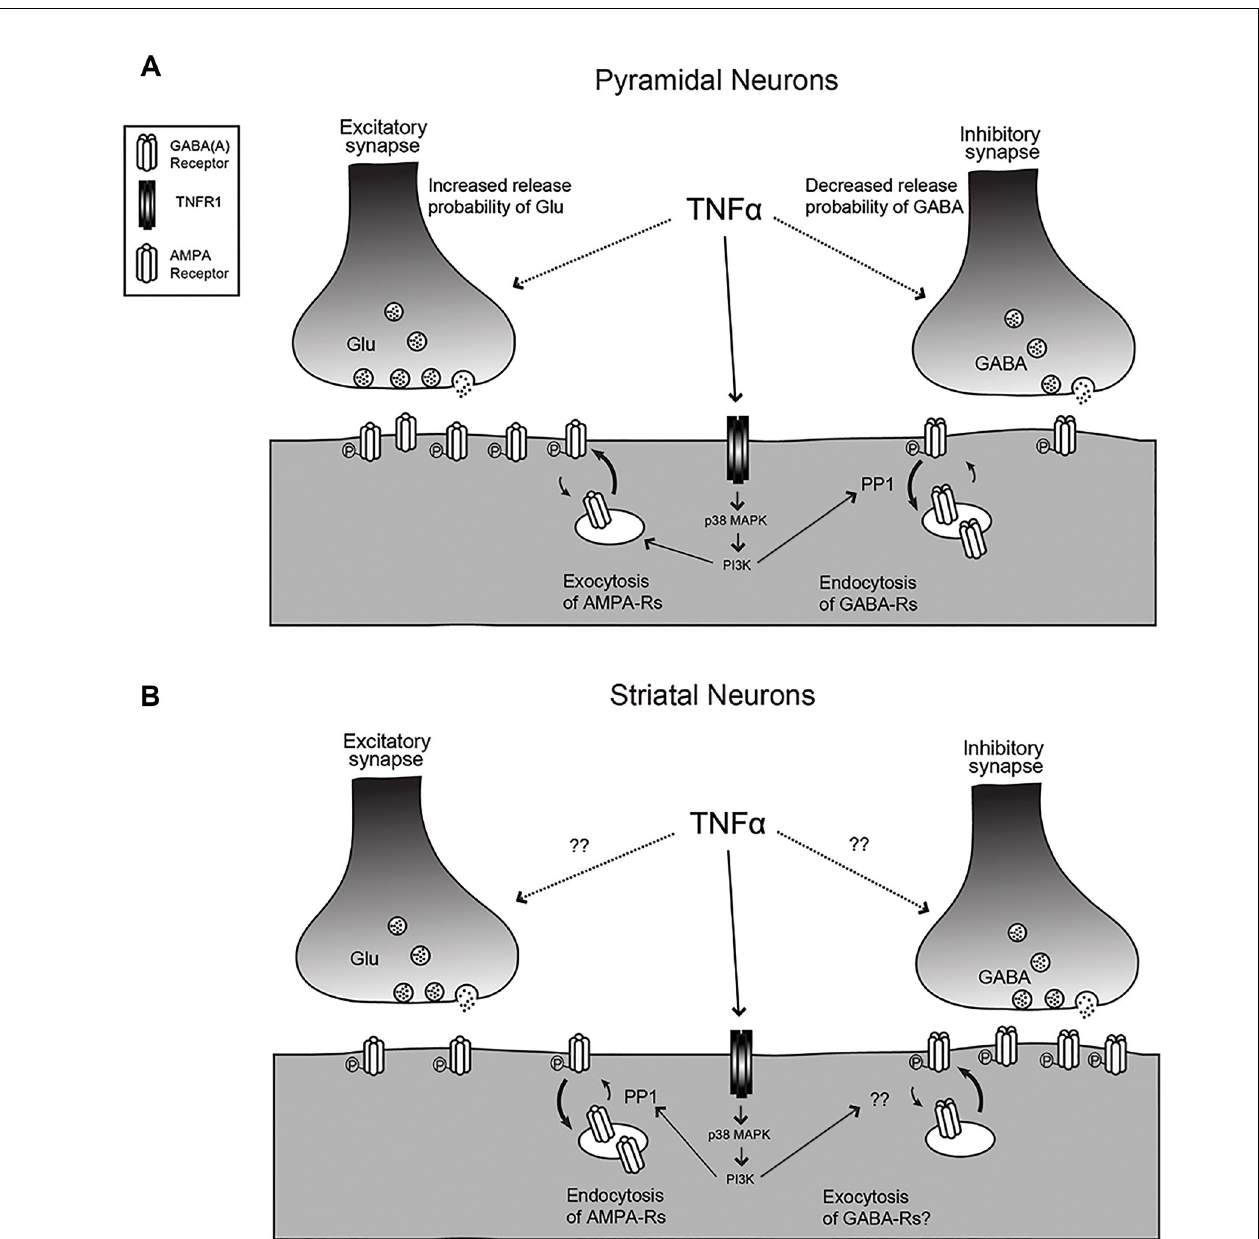
FIGURE 1 | The effects of tumor necrosis factor (TNF) on synaptic function. (A) For hippocampal or cortical pyramidal neurons, TNF treatment leads to an increase in release probability and an increase in AMPA receptor content at excitatory synapses but a decrease in release probability and decrease in GABA A receptor content at inhibitory synapses. The mechanisms for the change in release probability are unknown but the post-synaptic receptor trafficking requires p38-MAP kinase and PI3 kinase and the receptor endocytosis is dependent on protein phosphatase 1 (PP1). (B) The response is reversed for medium spiny neurons (MSNs) in the striatum and neurons in the habenula. Here, TNF causes endocytosis of AMPA receptors and may cause exocytosis of GABA receptors. Changes in release probability have not been documented. Figure adapted from Pribiag and Stellwagen